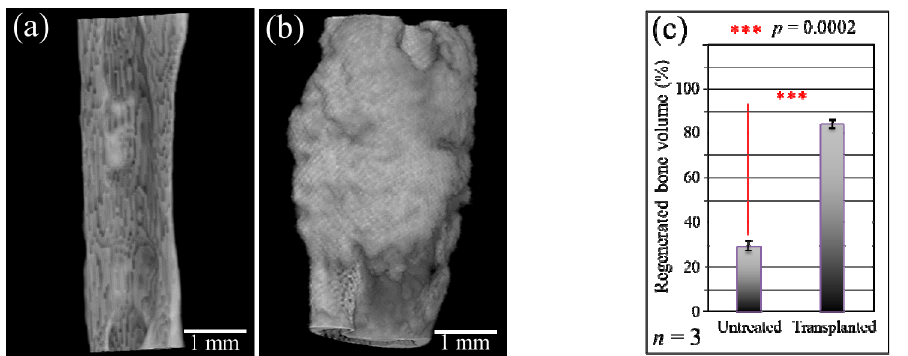
Figure 3. High-magnification µ CT images of the bone defect before ( a ) and after ( b ) regeneration; ( c ) shows the quantitative assessment of the volume fraction of regenerated bone in the untreated and the transplanted bone.